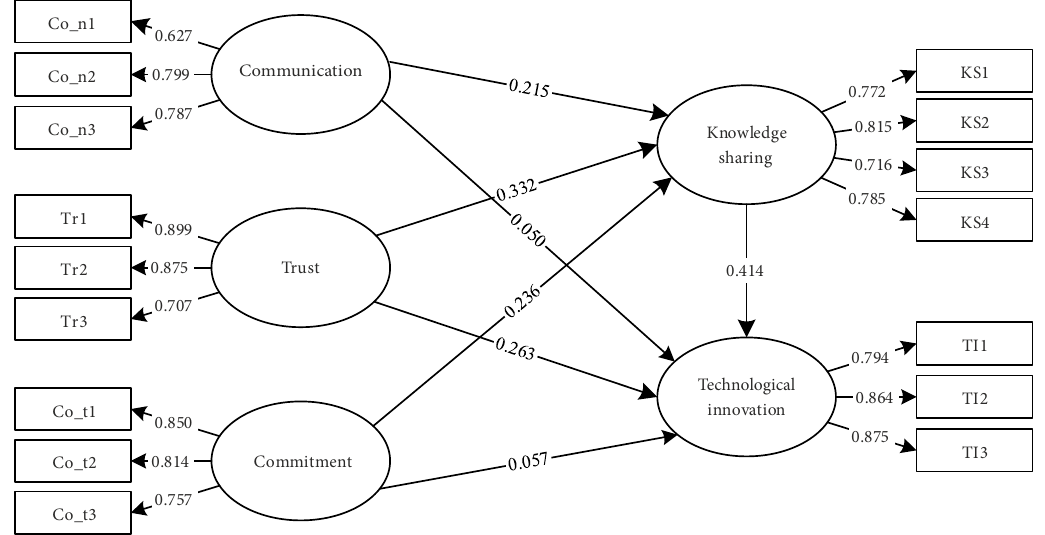
Figure 3. Results of the structural